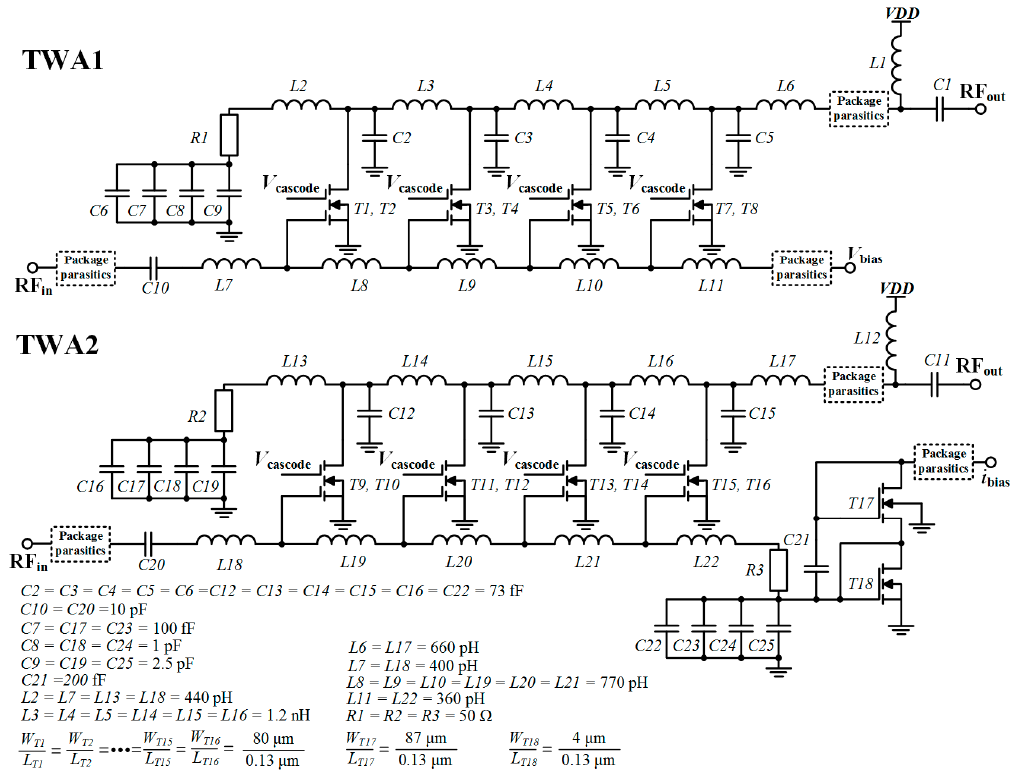
Figure 2. IBM 0.13 μ m CMOS traveling-wave amplifier chip simplified schematic. Figure 2. IBM 0.13 µ m CMOS traveling-wave amplifier chip simplified